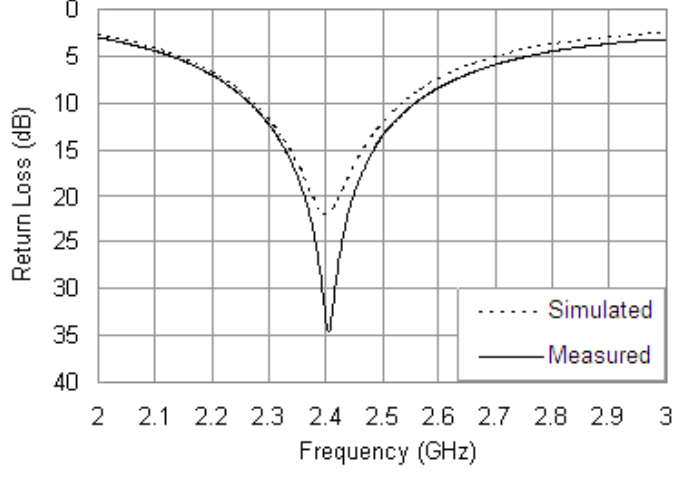
Figure 10. Measured and simulated return loss curves of the antenna along with the installation